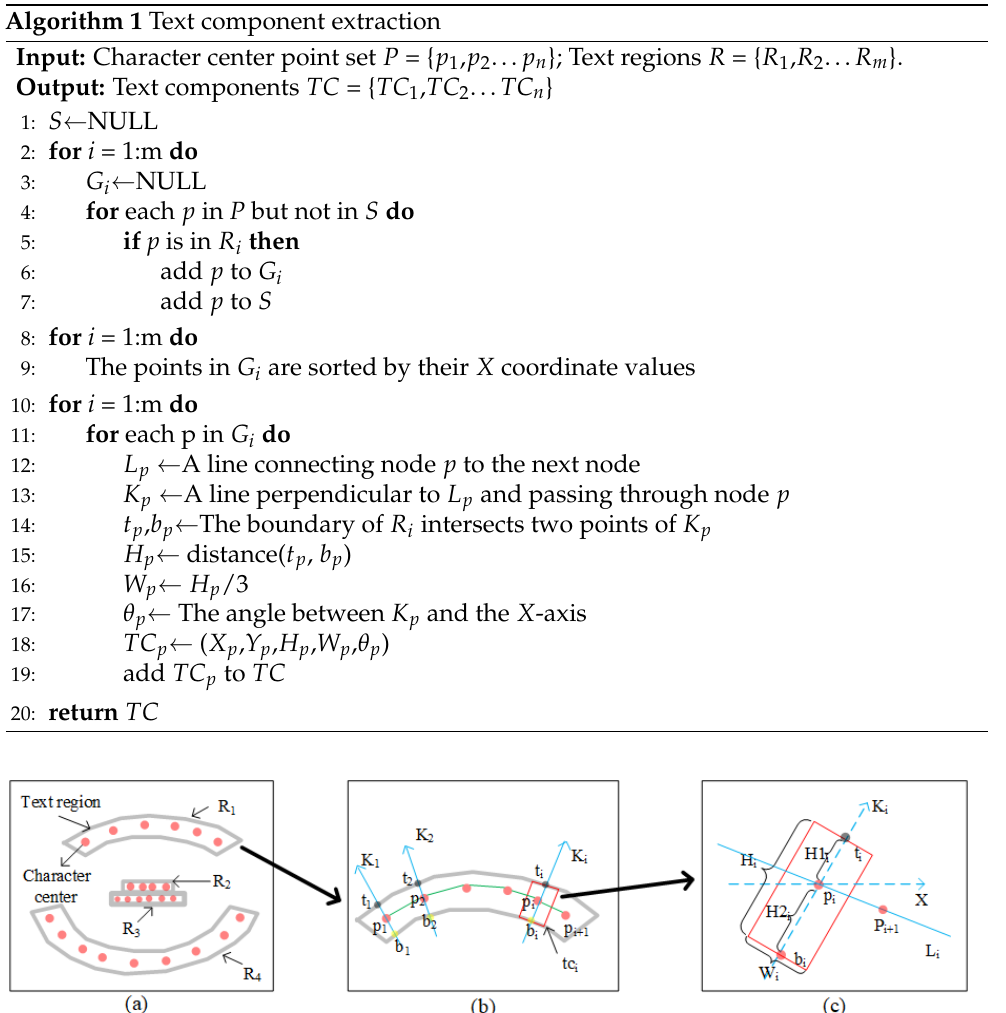
Algorithm 1 Text component extraction